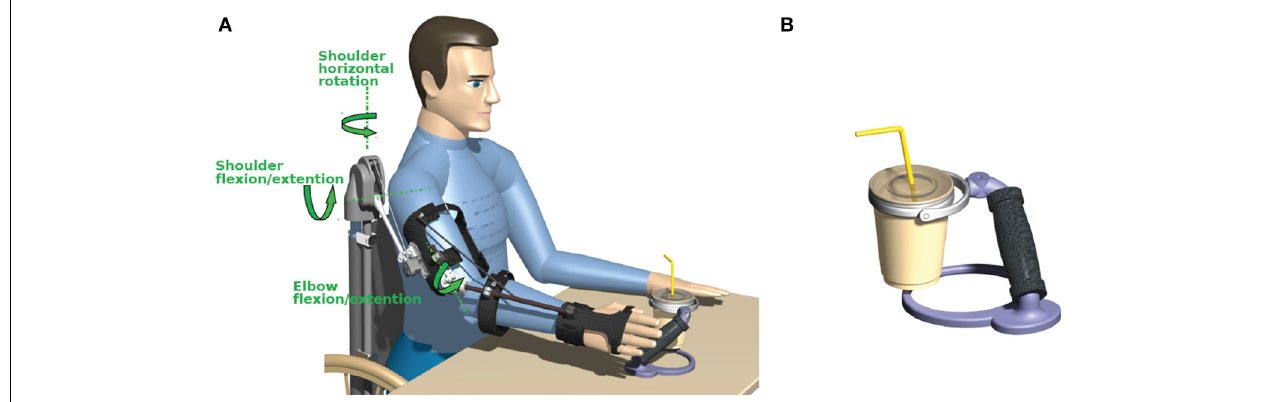
FIGURE 2 | (A) Exoskeleton with spring-based gravity compensation and electromagnetic brakes mounted on a wheelchair. (B) Cup holder with an universal joint in the handle.